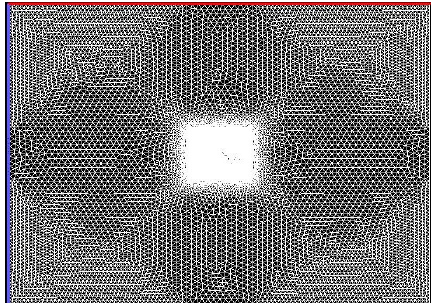
Figure 4. Computational grid on the bottom surface the domain. Total number of cells is 7,890,431.